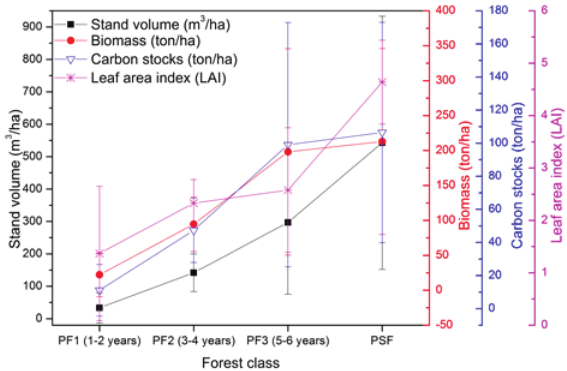
Figure 2 Biophysical parameters of peat swamp forest (PSF) and plantation forest